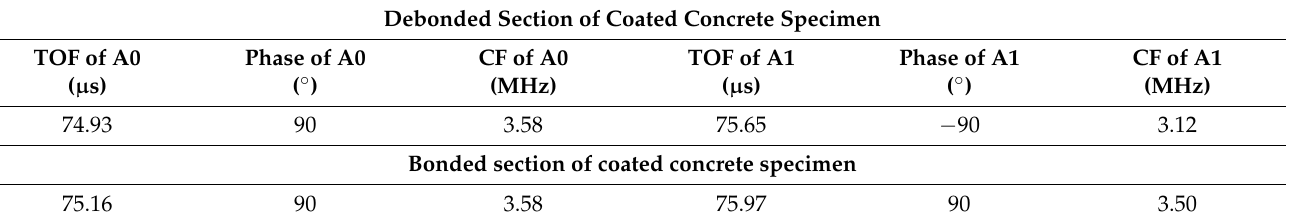
Figure 6. Time-domain waveform from bonded coating layer ( a ), the CWT of the time domain wave- form ( b ), and the projection of the CWT magnitude to the time domain ( c ).